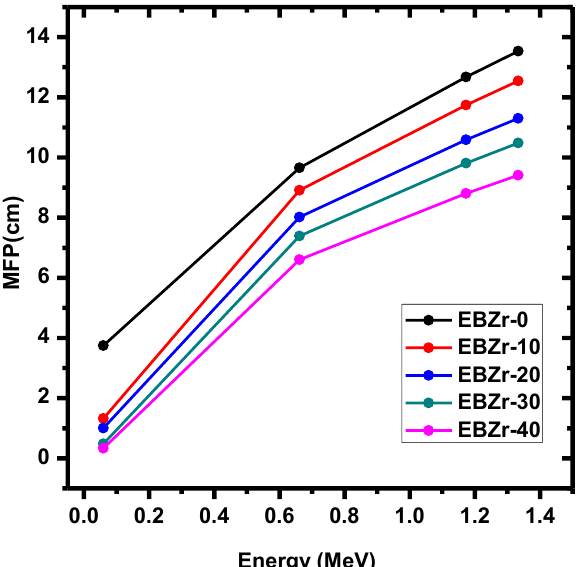
Figure 6. The variation of the mean free path values of epoxy with ZrO 2 .